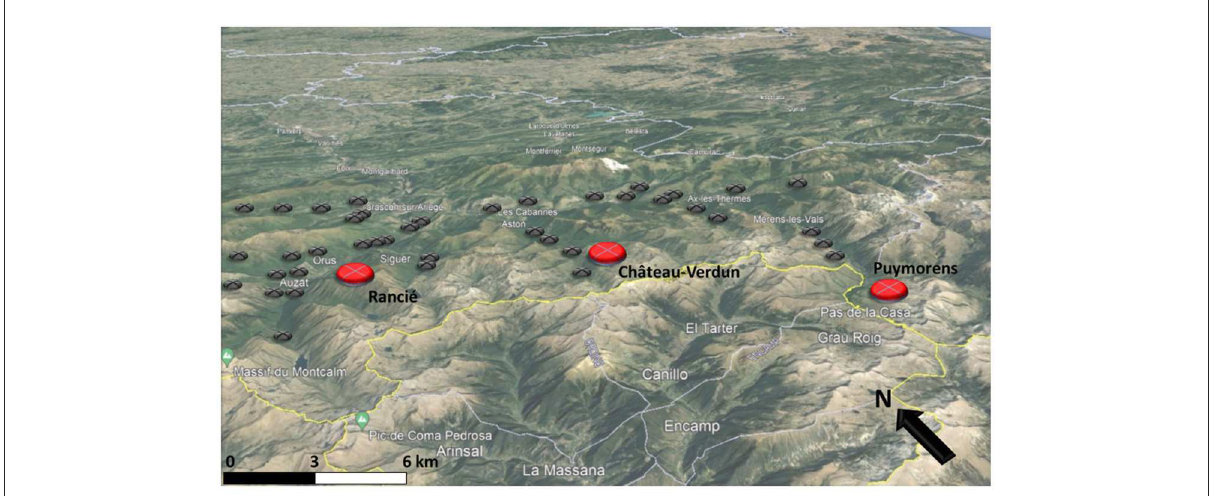
FIGURE1 Location of the mines of Puymorens and Rancié in the Pyrenees Mountains. Forges and ≪ moulines ≫ (gray dots) are found in all the valleys nearby these mines (red dots). Borders of Ariège & Pyrénées-Orientales Departments are in pale blue and international border with Andorra is in yellow. Adapted from Balent (2005) and Poujade